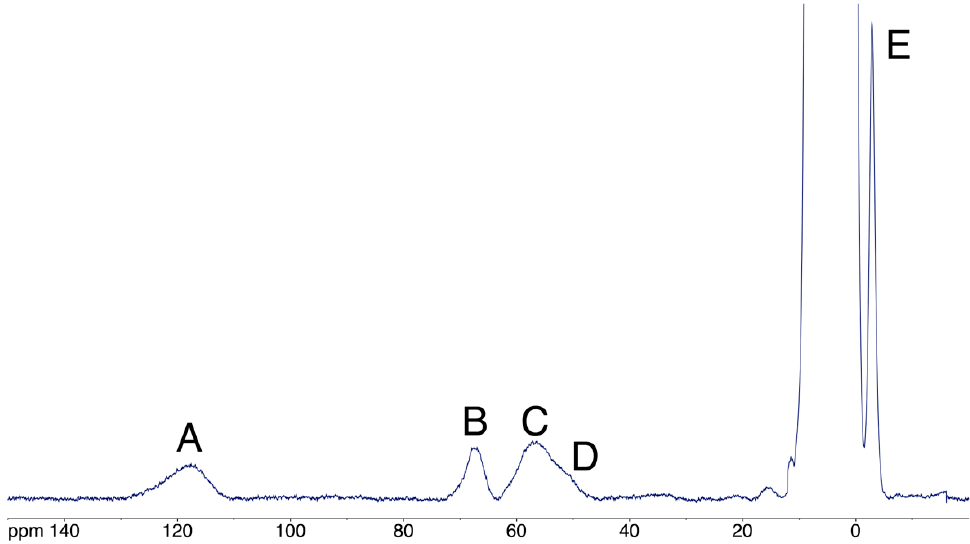
Figure 9. 1 H NMR spectrum of NDRG1*C at pH 7.5 and 298 K in the presence of 4 equiv. Ni(II). Signals A, B, C, D and E are relative to nuclei sensing the hyperfine shift (contact and pseudo-con- tact) due to the presence of the paramagnetic Ni(II) S = 1 ion bound to h